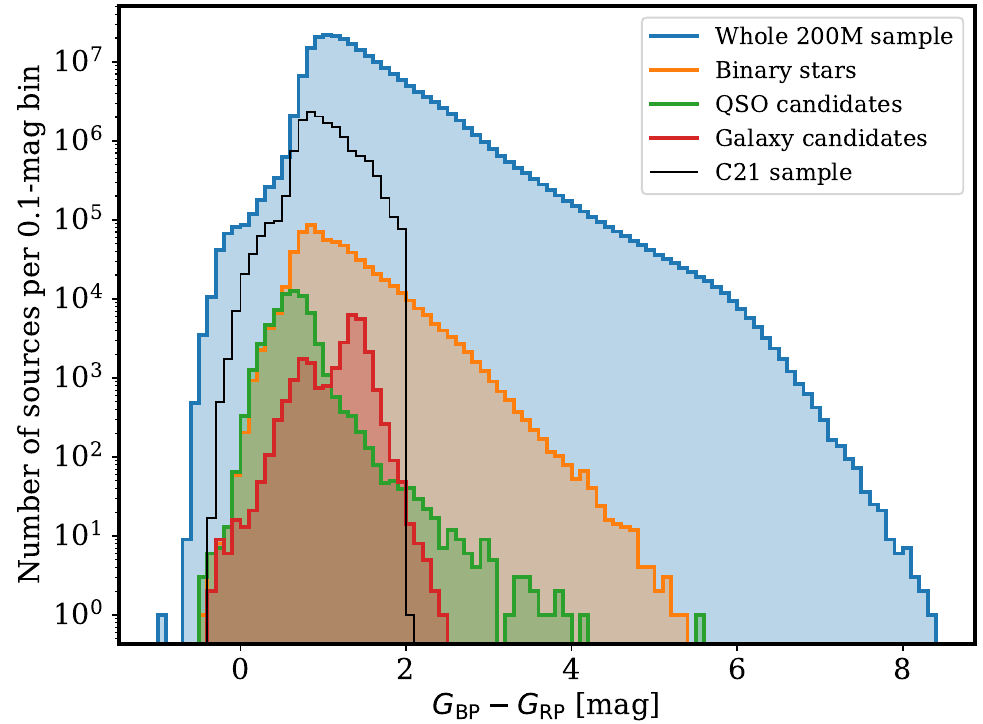
Figure 7. Histogram of the 200 M sample as a function of G BP − G RP colour in bins of 0.1 mag. The whole 200 M sample is displayed in blue, whereas the subsamples corresponding to sources flagged in Gaia DR3 as non_single_star , in_qso_candidates and in_galaxy_candidates are dis- played in orange, green and red, respectively. In addition, the histogram corresponding to the C21 sample is displayed with a thin black line, which is limited to − 0.5 ≤ G BP − G RP ≤ 2.0